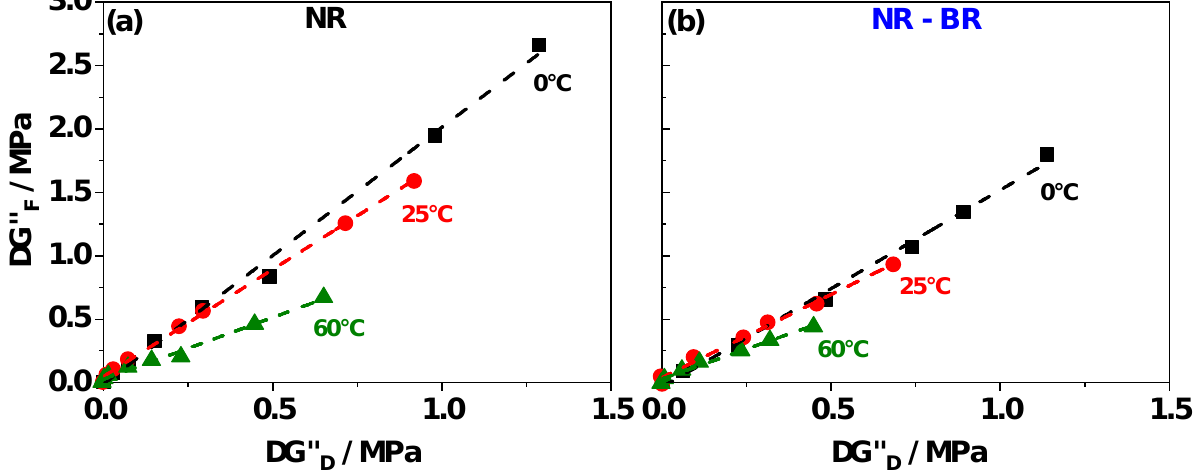
vs . ∆ G (cid:48)(cid:48) F